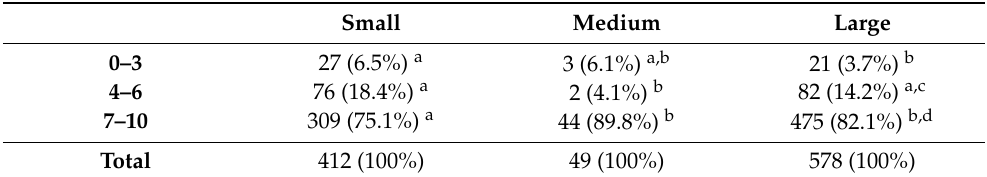
Table 6. Distribution (expressed as number and %) of the 1039 live-born puppies in the viability classes according to the BBS.